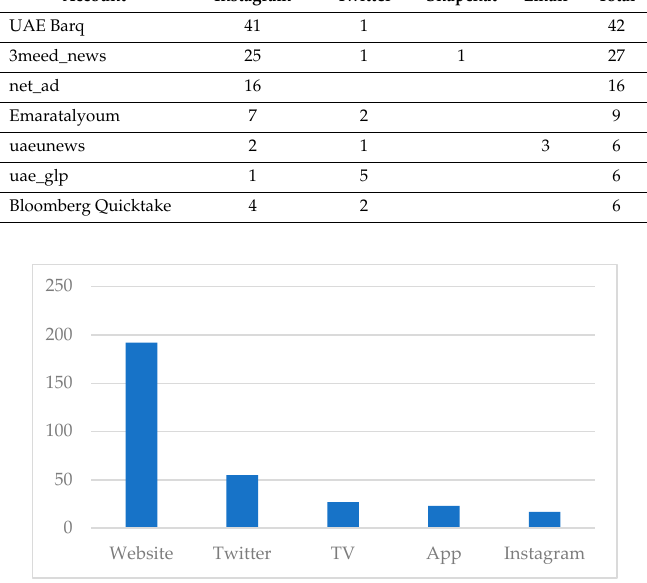
Figure 2. Top five platforms used to access all media.